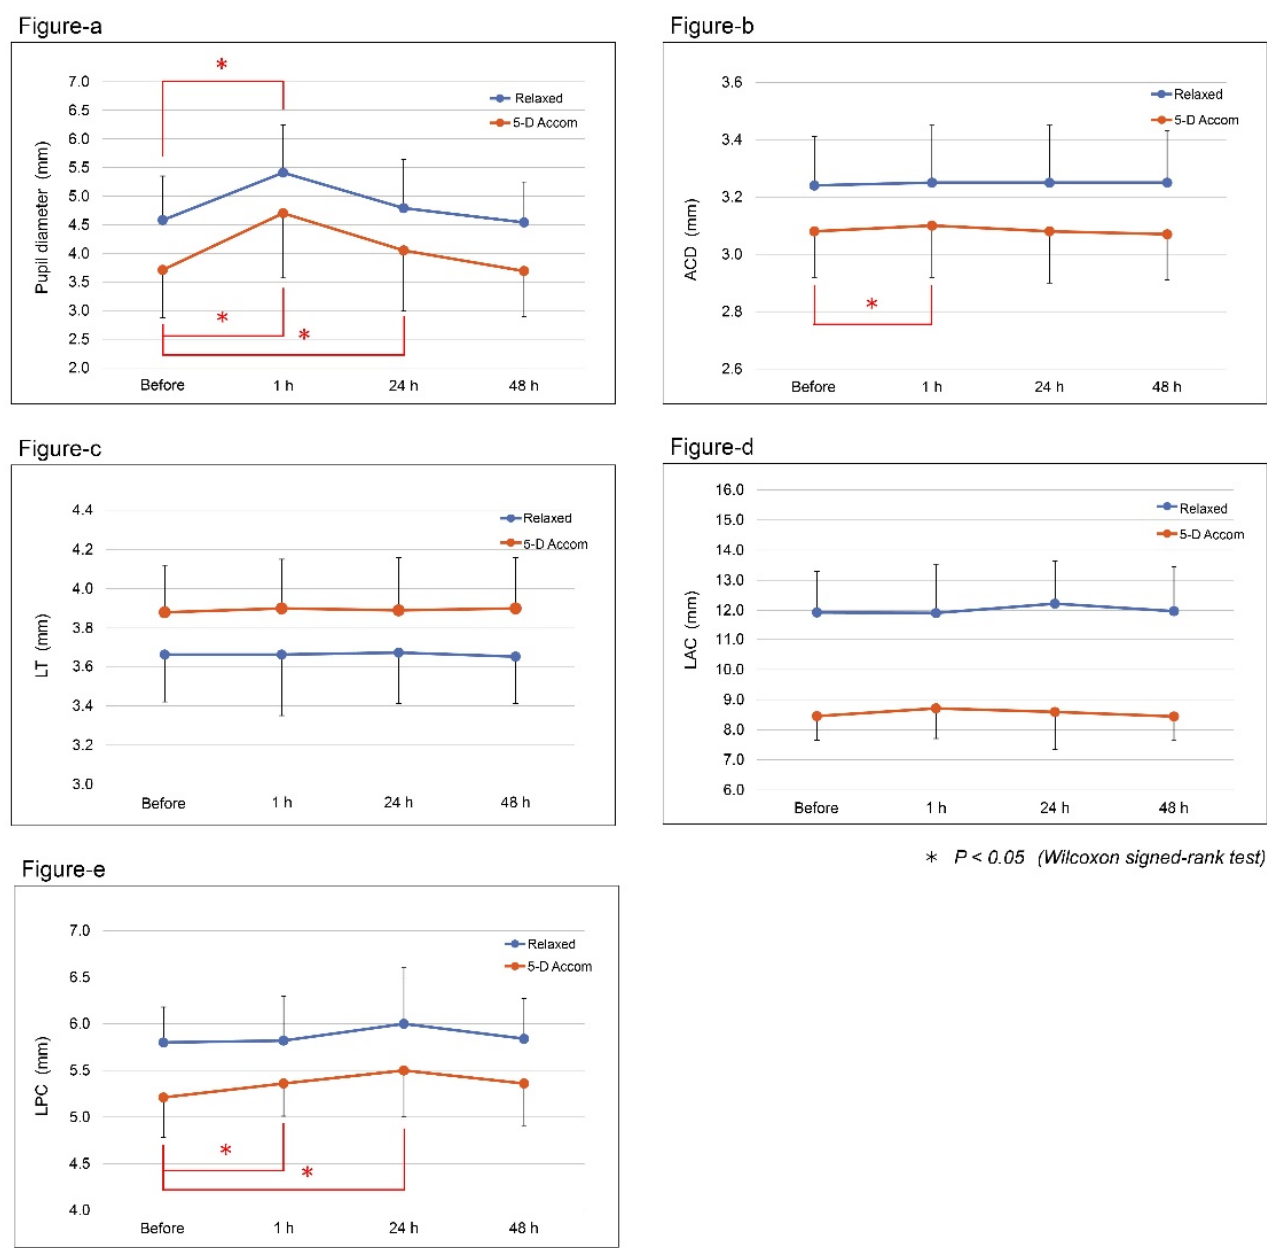
Figure 1. Change in biometric parameters after the instillation of 0.01% atropine eye drops. Shown is a comparison of the biometric parameters in the relaxed state (Relaxed) and with the 5 D accommodative stimulus (5-D Accom) before and 1, 24, and 48 h after instillation of 0.01% atropine eye drops. ( a ) The pupil diameter increased significantly 1 h after instillation in the relaxed state but returned to the pre-instillation level at 24 h. With the 5 D accommodative stimulus, the pupil diameter significantly increased at 1 and 24 h but returned to the pre-instillation level at 48 h. ( b – e ) In the non-accommodative eyes, none of the assessed biometric parameters (ACD, LT, LAC, LPC), with the exception of pupil diameter, showed changes at any time point when compared to that before the instillation. However, with the 5 D accommodative stimulus, ACD significantly increased at 1 h ( b ) and LPC significantly increased at 1 and 24 h ( e ) after atropine instillation when compared with that before instillation ( p < 0.05). D, diopter; ACD, anterior chamber depth; LT, lens thickness; LAC, horizontal radius of the lens’ anterior surface curvature; LPC, horizontal radius of the lens’ posterior surface curvature. * p < 0.05, Wilcoxon signed-rank test.